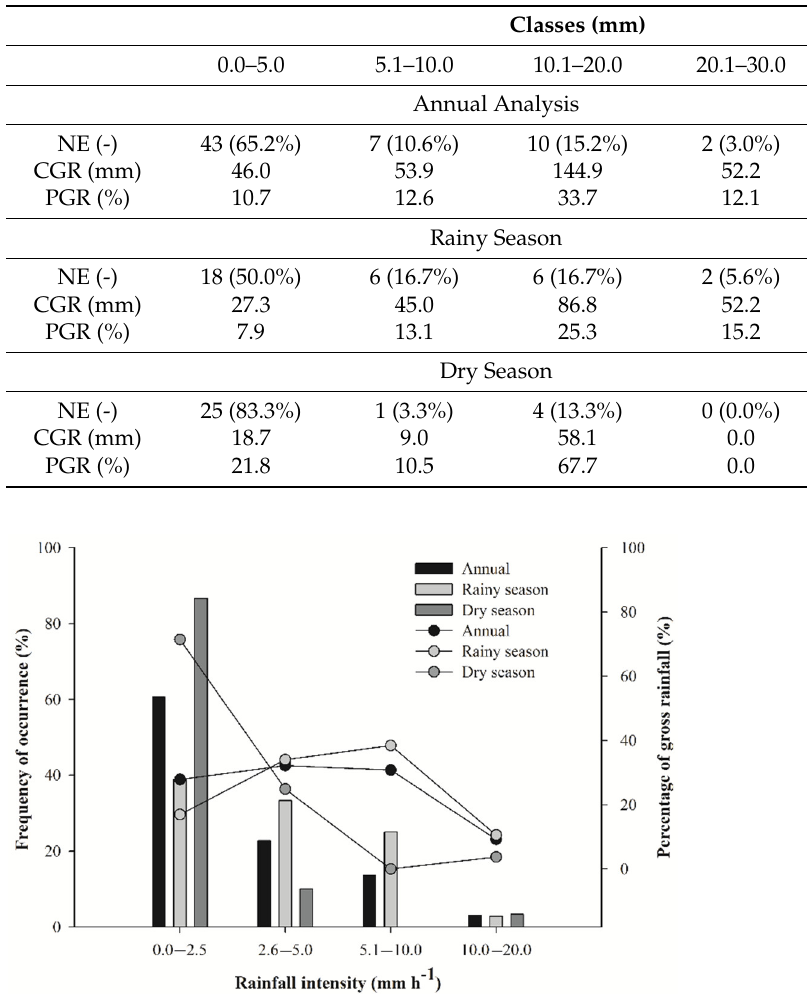
Figure 2. Frequency distributions (bars) and percentages of gross rainfall of the intensity of rainfall events (lines) at the Caatinga domain in Brazil during the measurement period (annual, rainy and dry seasons) from 1 March 2016 to 30 September